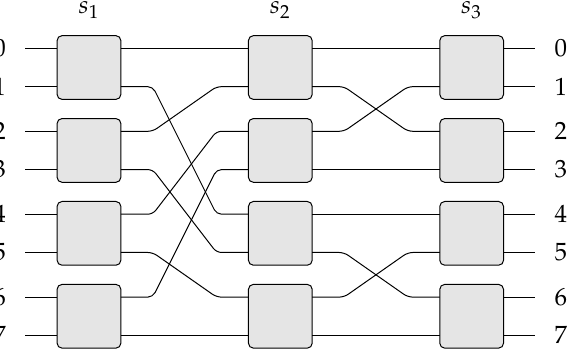
Figure 1. The banyan switching fabric of 8 inputs and 8 outputs (also called the log As the competitive structure to the banyan -type switching fabric, the log ing fabric was introduced in [15], and later it was formally described in [16], where N denotes the number of inputs/outputs of switching fabric. It was shown that the log switching fabric is a better solution for optical switching than the baseline switching net- work [17], where baseline constitutes a permutation pattern used in the banyan switching network. The multiplane version of the mentioned switching architecture is called the N − 1 switching fabric, and it was described in detail in [16] as well. A multi- multi-log 2 N − 1 switching network is achieved by vertically stacking p copies of the plane multi-log 2 N − 1 structure. The general idea of the multiplane (in general, p -plane) switching log 2 network is shown in Figure 2.